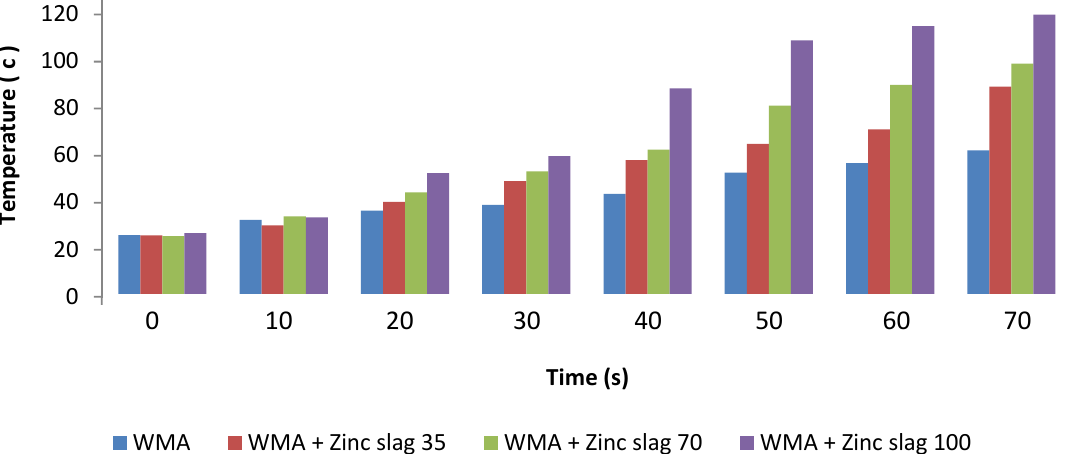
Figure 11. The healing of the samples under microwave heating at ( a ) 40-s, ( b ) 50-s, and ( c ) 60-s cycle durations.